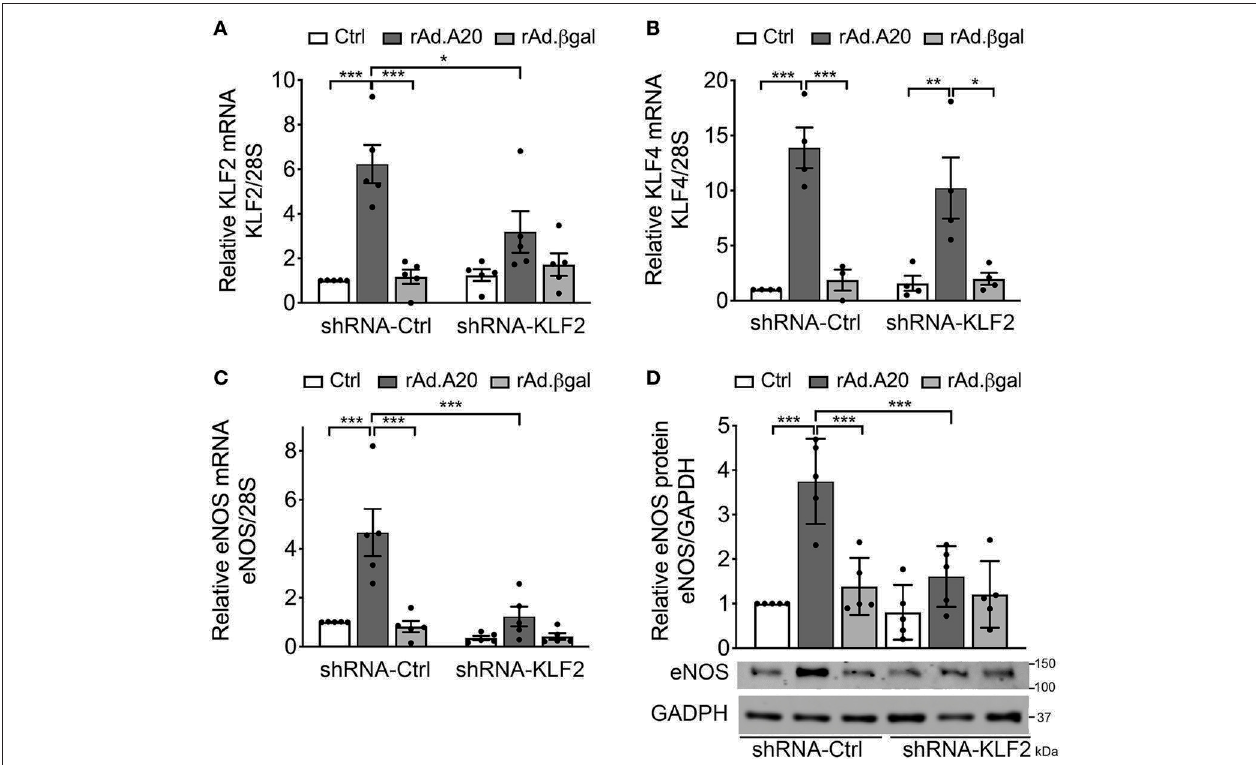
FIGURE 4 | A20 overexpression in HCAEC increases eNOS transcription in a KLF2-dependent manner. HCAEC were transduced with 100 MOI of shRNA-KLF2 or scramble shRNA-Ctrl for 24h, then retransduced with rAd.A20 or control rAd. β gal at 200–250 MOI for 48h or left non-transduced (Ctrl). Cell lysates were evaluated by qPCR for mRNA levels of (A) KLF2, (B) KLF4, and (C) eNOS. Graphs shown depict relative mRNA levels, normalized by the 28S HKG and expressed as mean ± SEM fold change of Ctrl shRNA-Ctrl cells ( n = 3–6) and by (D) WB for eNOS protein expression. GAPDH was used to correct for loading. Densitometry results are presented as fold change of Ctrl shRNA-Ctrl cells and expressed as mean ± SEM ( n = 4). * p < 0.05, ** p < 0.01, *** p < 0.001, as determined by two-way ANOVA followed by the Bonferroni post hoc